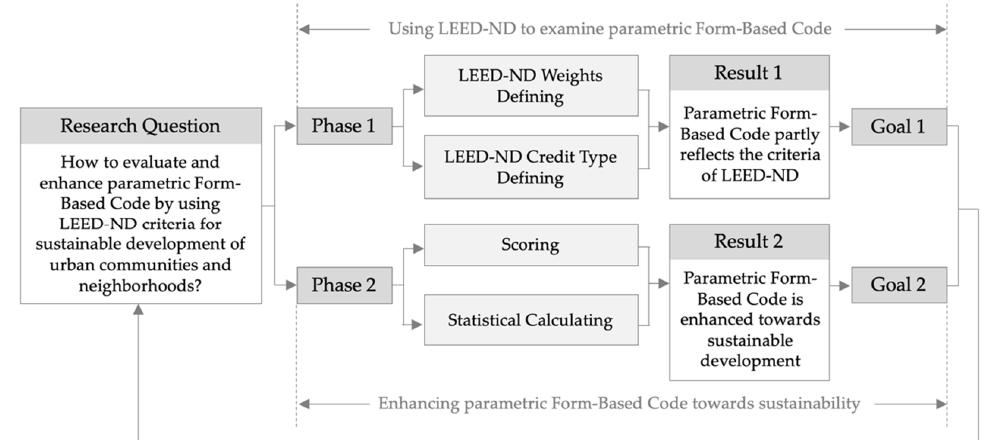
Figure 1. Methodological framework.